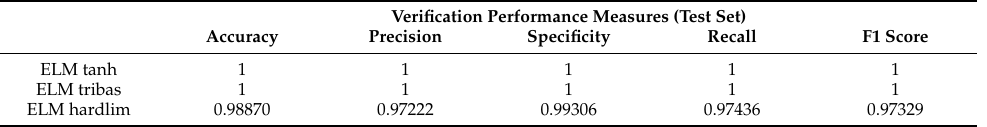
Table 12. Verification (test) classification performance measures of the ELM classifier for three different transfer functions of the ELM algorithm in dataset #2.